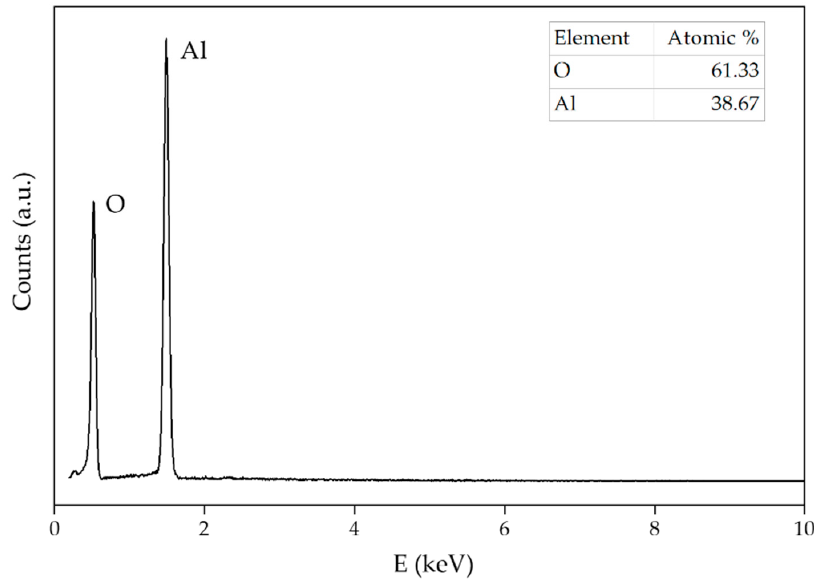
Figure 7. SEM images of alumina NPs at ( a ) 20,000× and ( b ) 50,000× magnification.